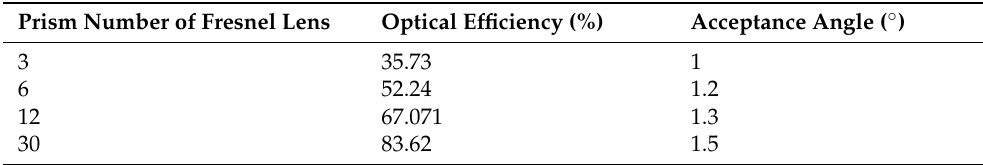
Table 1. Optical e ffi ciency and acceptance angle vs. prism Table 1. Optical efficiency and acceptance angle vs. prism number.